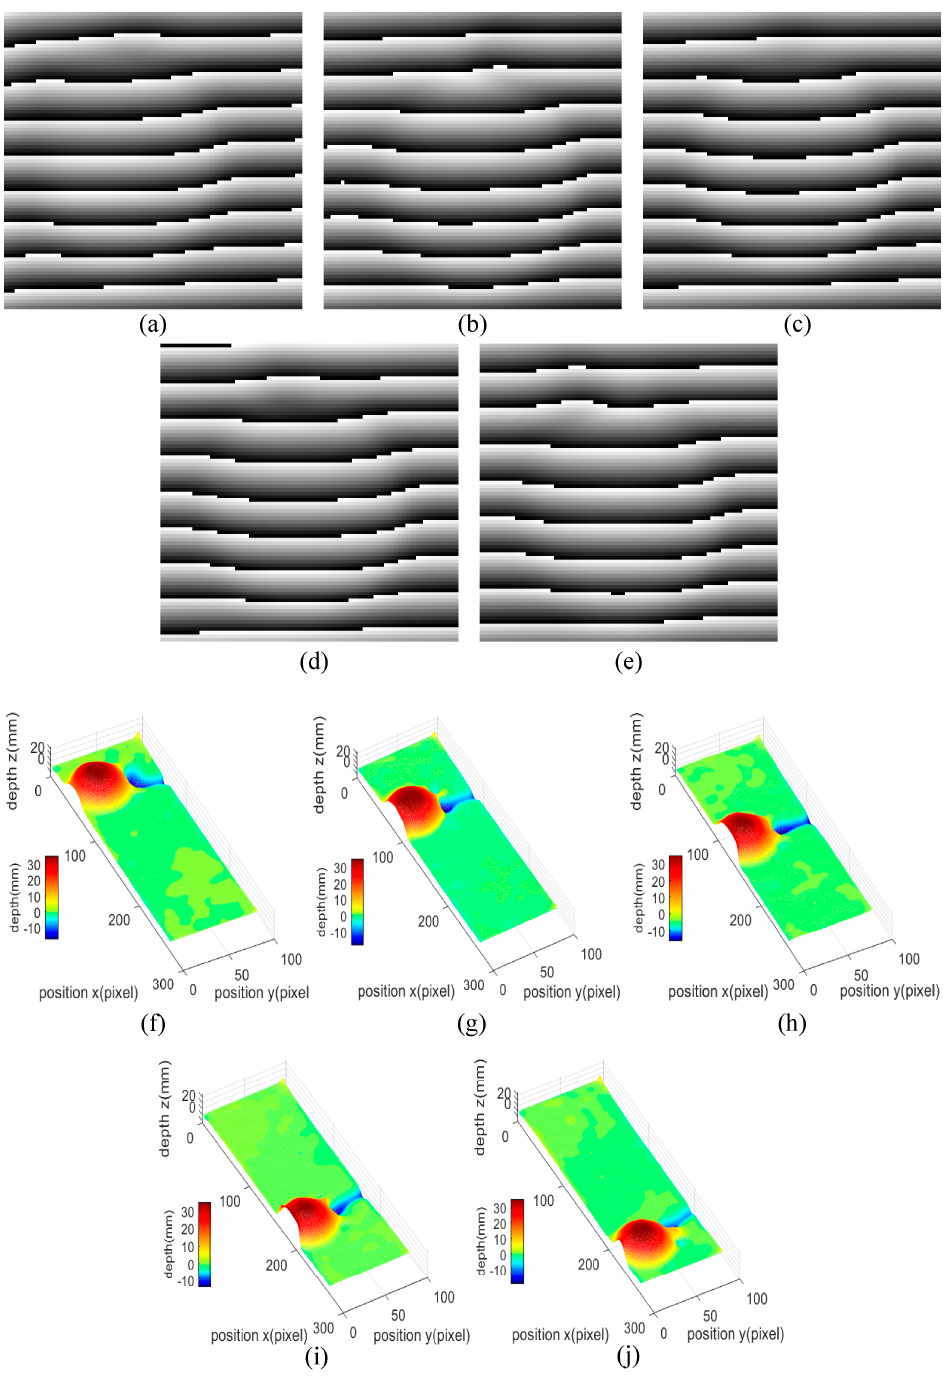
Figure 7. 2D phase maps of the pendulum ball at frames ( a ) 6, ( b ) 9, ( c ) 12, ( d ) 15, ( e ) 18. Real-time dynamic 3D shape reconstruction results of the pendulum ball at frames ( f ) 6, ( g ) 9, ( h ) 12, ( i ) 15, ( j ) 18.